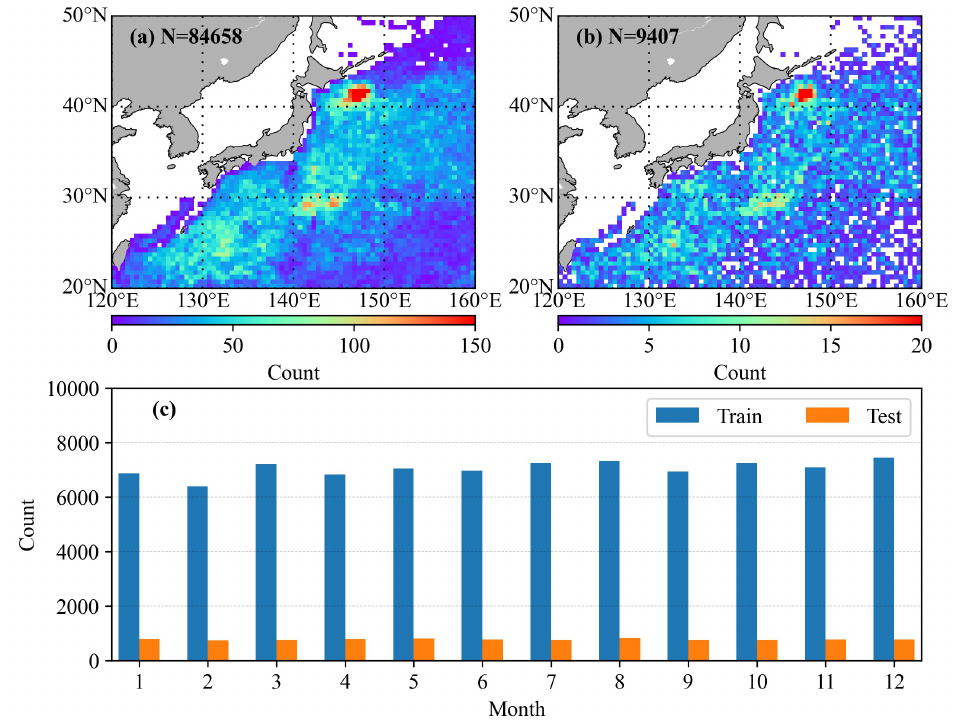
Figure 1. The data density of Argo profiles in 1999–2018 at a spatial bin of 0.5 ◦ in both latitude and longitude divided for ( a ) training and ( b ) independent testing. ( c ) The monthly data count for training and